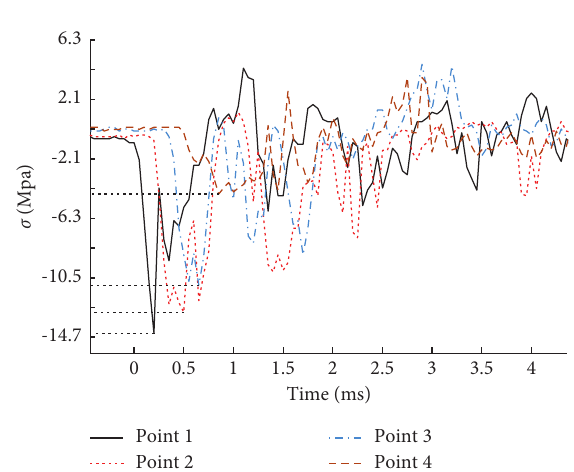
Figure 11: Curves of impact stress on drill different positions.